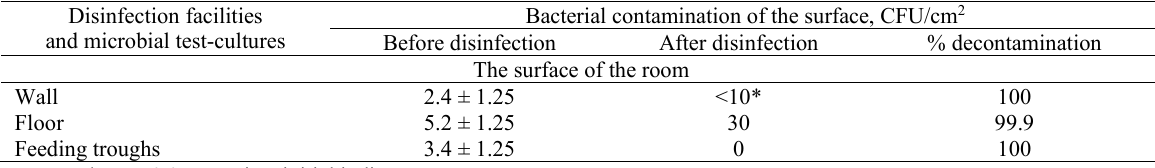
Effectiveness of disinfection of premises in the presence of broiler chickens with the disinfectant of 0.2 % Biolide and probiotic Biozapin, thousand/cm 2 , M ± m, n = 5 Disinfection